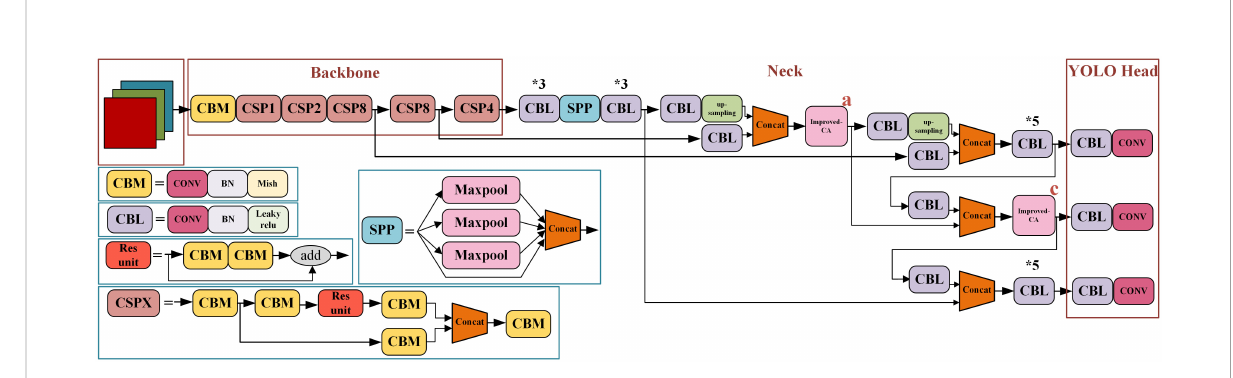
FIGURE 10 The improved YOLOv4 network structure diagram. * means repeat the